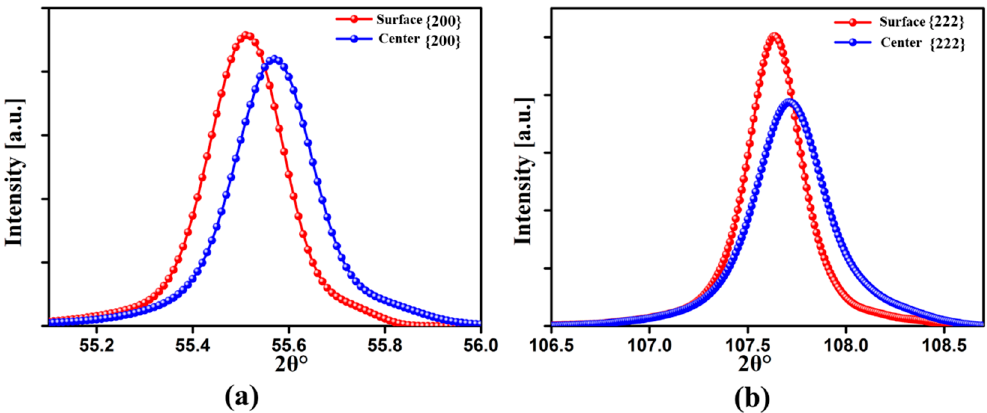
Figure 2. The Orientation distribution function (ODF) sections ( φ 2 = 45°) of 70% clock-rolled Ta plates along the thickness: ( a ) Surface layer, ( b ) center layer.